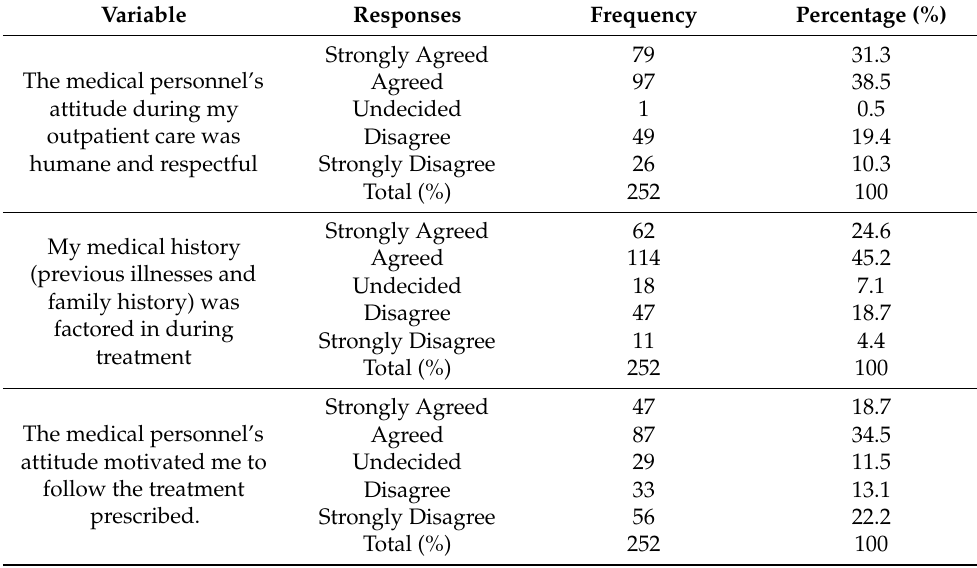
Table 2. Distribution of respondents’ perception of the attitude of medical personnel. Variable